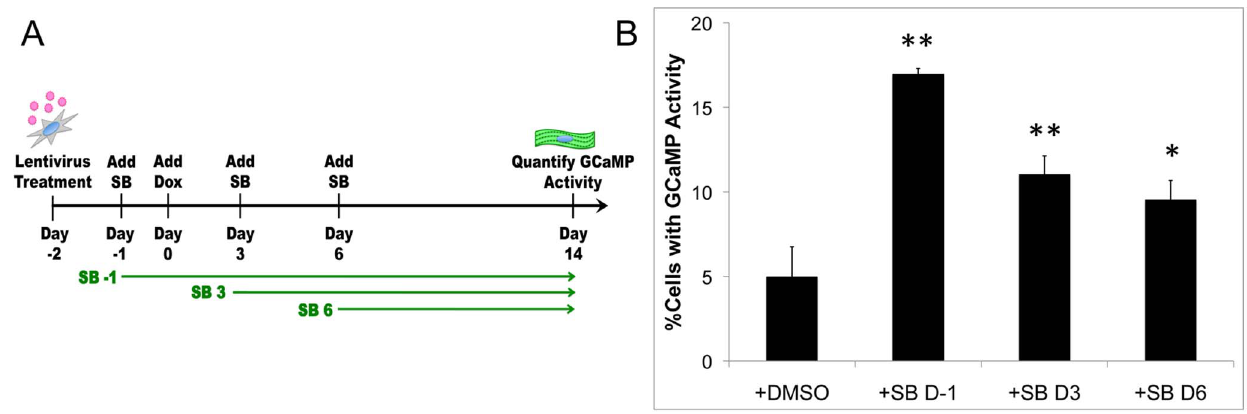
Figure 2. Inhibition of TGF b early in the conversion process leads to the greatest increase in iCM yield. Schematic depicting the addition of SB at different time points following induction of the transcription factors (A). Quantification at Day 14 of the number of cells with Troponin T-GCaMP activity upon addition of SB at Day -1 (D-1), 3 (D3), and 6 (D6) (B). * indicates p , 0.05 and ** indicates p , 0.01 compared to + DMSO